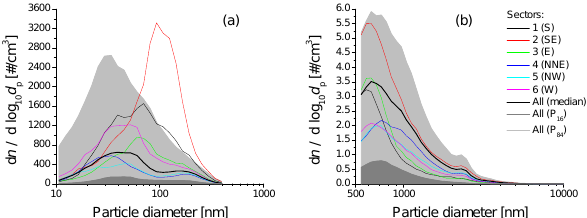
Fig. 4. Median size distributions (thicker black line) and 16th and 84th percentile distributions (shaded areas) for the: (a) submicrometer particles, (b) micrometer particles. The colored lines represent the median size distributions observed in different air masses.